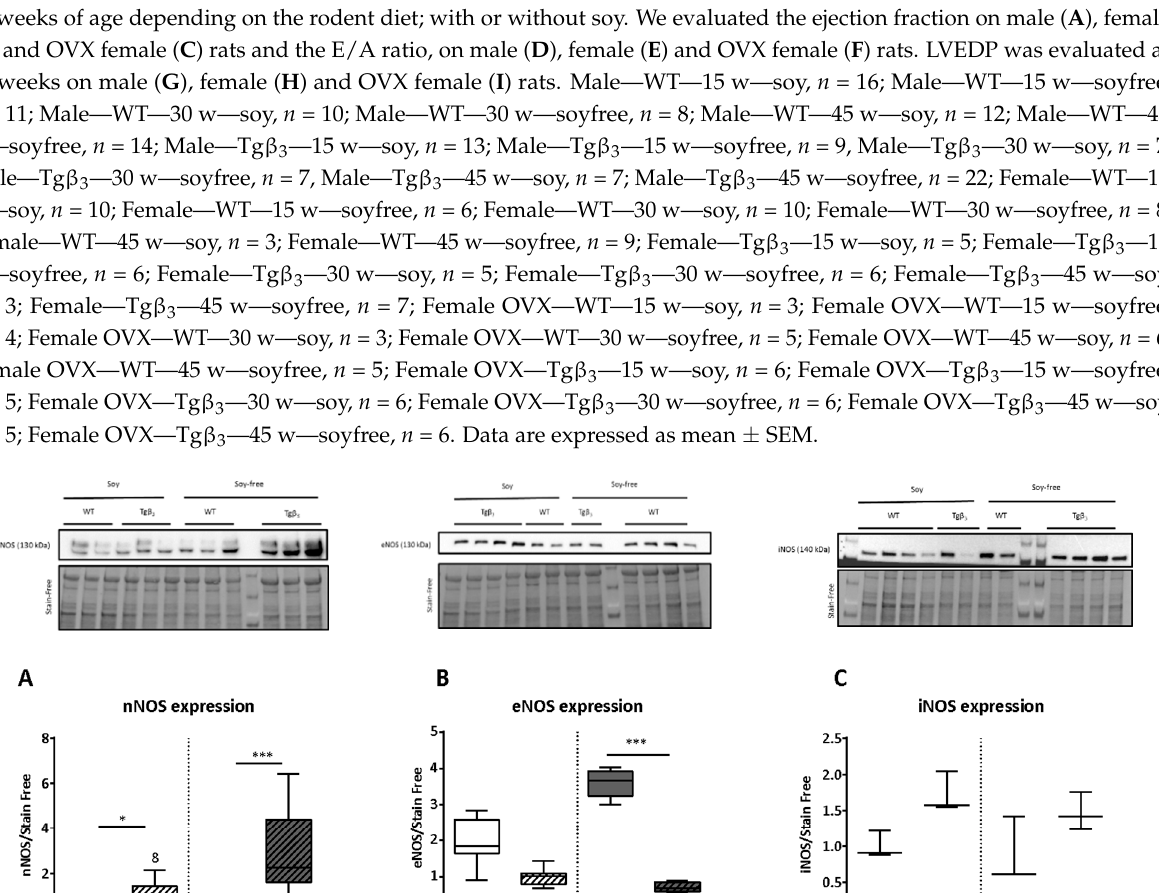
Figure 1. Echocardiography study at 15, 30 and 45 weeks of age and invasive hemodynamic study at 45 weeks of age depending on the rodent diet; with or without soy. We evaluated the ejection fraction on male ( A ), female ( B ) and ovari- ectomized (OVX) female ( C ) rats and the E/A ratio, on male ( D ), female ( E ) and OVX female ( F ) rats. Left ventricle (LV) and end-diastolic pressure (LVEDP) was evaluated at 45 weeks on male ( G ), female ( H ) and OVX female ( I ) rats. Data are expressed as mean ± SEM ***: p < 0.001. Echocardiography study at 15, 30 and 45 weeks of age and invasive hemodynamic study at 45 weeks of age depending on the rodent diet; with or without soy. We evaluated the ejection fraction on male ( A ), female ( B ) and OVX female ( C ) rats and the E/A ratio, on male ( D ), female ( E ) and OVX female ( F ) rats. LVEDP was evaluated at 45 weeks on male ( G ), female ( H ) and OVX female ( I ) rats. Male—WT—15 w—soy, n = 16; Male—WT—15